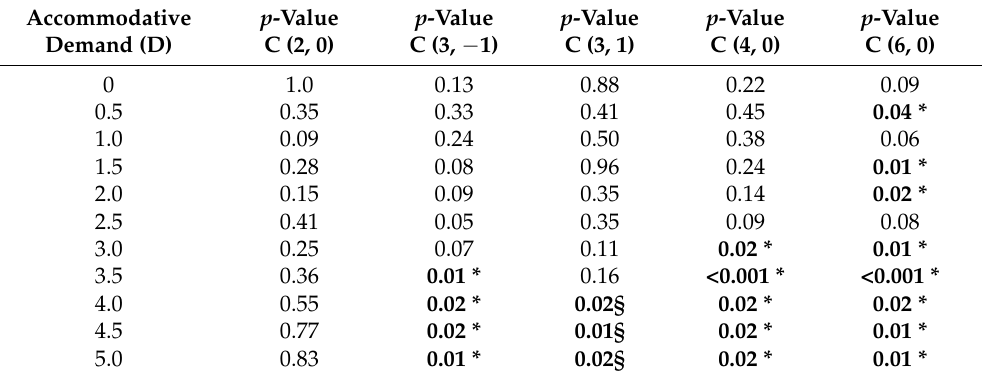
Table 1. Wilcoxon test or paired t -test values obtained for Zernike coefficients 𝐶 20 , 𝐶 3−1 , 𝐶 31 , 𝐶 40 and 𝐶 60 for each accommodative demand between measurements carried out with and without PHCl instillation conditions.